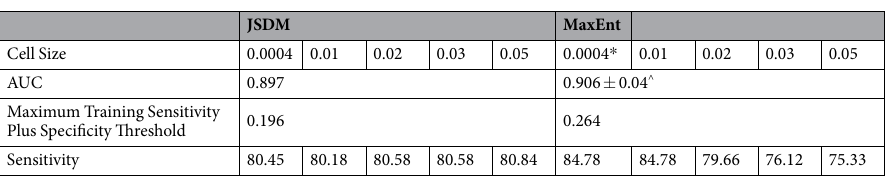
Table 2. Model performance as measured by AUC (Area Under the Curve) and sensitivity. Sensitivity was calculated by applying the Maximum Training Sensitivity Plus Specificity Threshold for five cell sizes. The Maximum Training Sensitivity Plus Specificity Threshold is the average value calculated over 100 iterations. * Original cell size used by the algorithm. ^ Standard